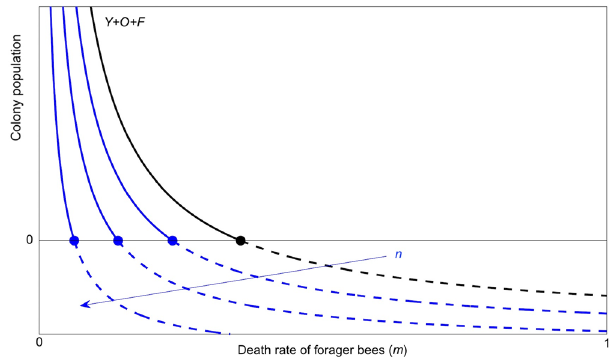
Fig. 4 | Dependence of the colony population at equilibrium on the death rate m of forager bees for varying death rate n of juveniles hive bees. For a forager death rate m exceeding a criticalvalue (black dot) the only stable equilibrium is zero, corresponding to colony failure. The premature death of hive bees (denoted by increasing values of n , represented by the blue curves) moves that critical value left, meaning that colony failure can occur for lower foragers ’ death rates. Black line: n =0, blue: n 2 (0, 1), dots: m ( n ). The parameter values are L =2000, w =27,000, α =0.25, and σ =0.75 as in a previously published report 50